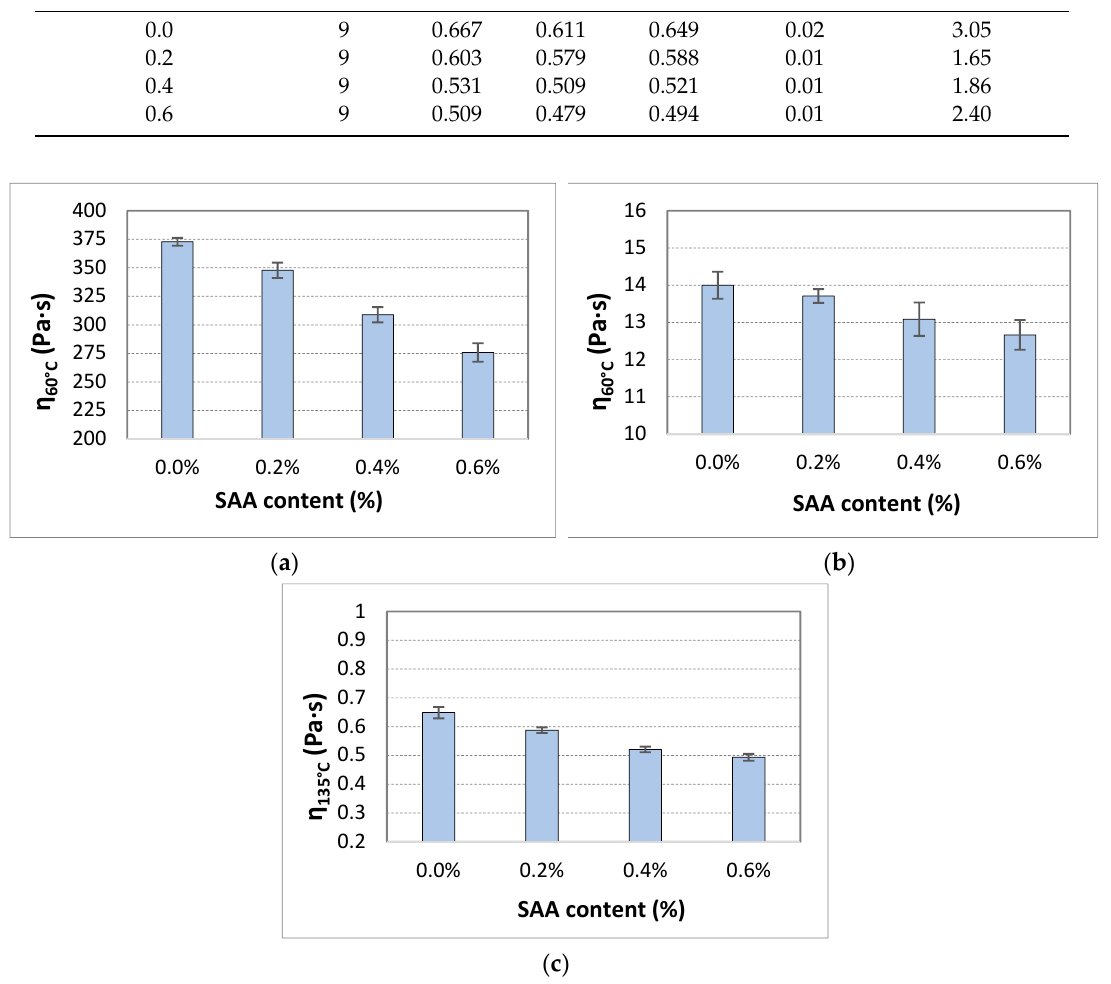
Figure 2. Effect of SAA addition on dynamic viscosity of 50/70 bitumen (box plot) at temperatures a ) Figure 2. E ff ect of SAA addition on dynamic viscosity of 50 / 70 bitumen (box plot) at temperatures a ) 60 °C, b ) 90 °C, c ) 135 °C (error bars represent standard deviation). 60 ◦ C, b ) 90 ◦ C, c ) 135 ◦ C (error bars represent standard